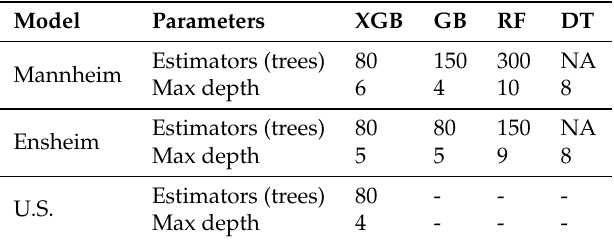
Table 5. Parameters for machine learning